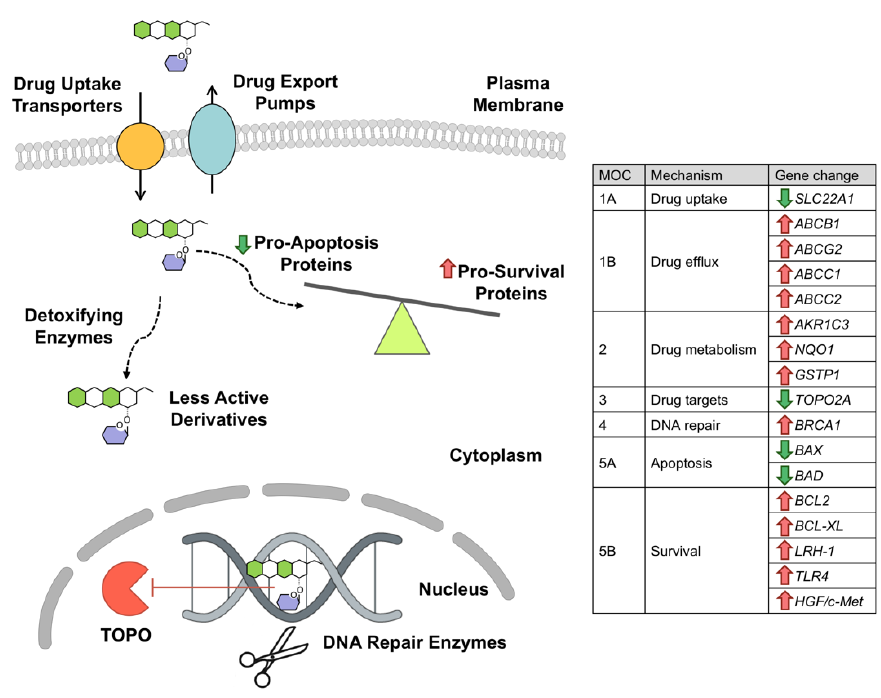
Figure 2. Schematic representation of mechanisms involved in chemoresistance (MOC) of hepatoblastoma to anthracyclines. The table indicates the change in hepatoblastoma of the expression levels of genes involved in the chemoresistance to anthracyclines: uptake transporters (MOC-1A), export pumps (MOC-1B), detoxifying enzymes (MOC-2), molecular targets (MOC-3), DNA repair enzymes (MOC-4), pro-apoptotic proteins (MOC-5A) and anti-apoptotic proteins (MOC-5B). TOPO, topoisomerase.